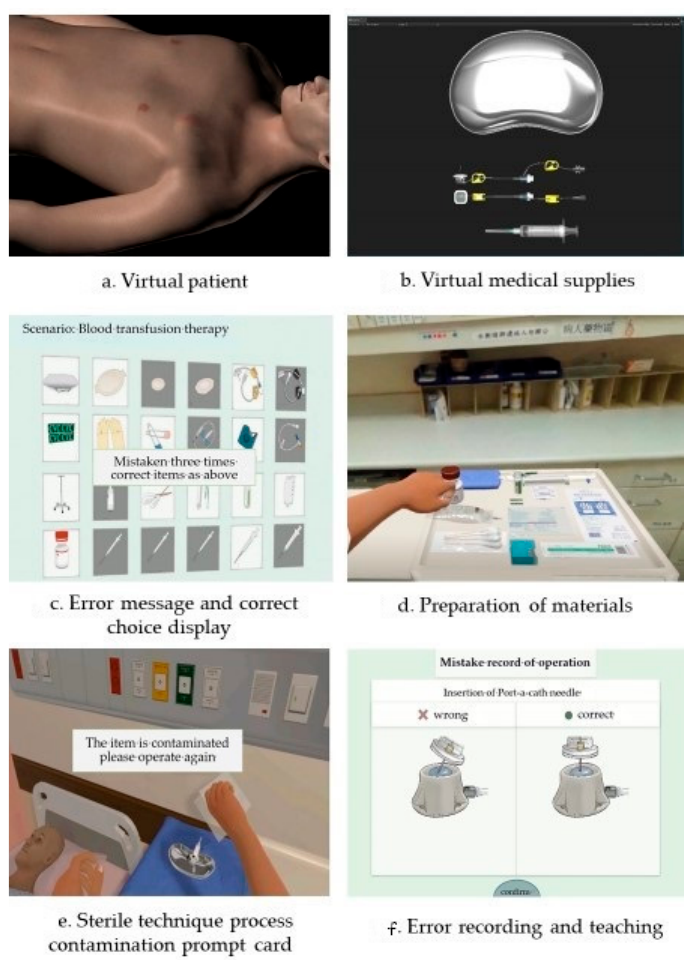
Figure 2. The learning process of the virtual reality teaching system.